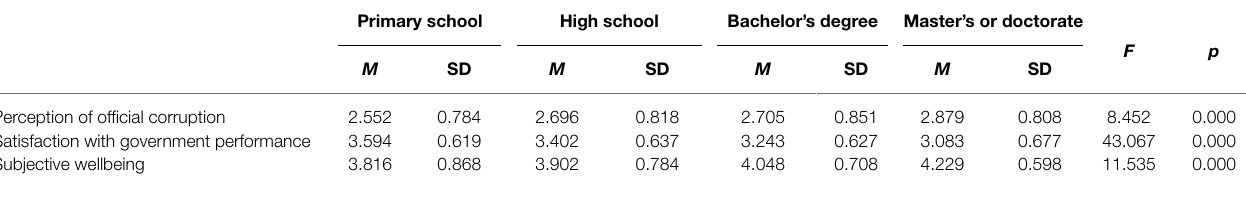
TABLE 3 | The differences of variables between different educational